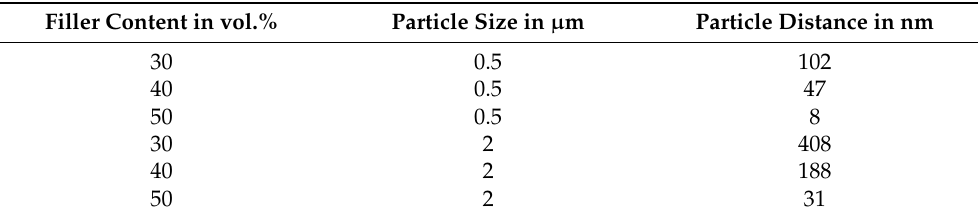
Table 1. Theoretical distances between the individual particles in PLA calculated according to [18]. Filler Content in